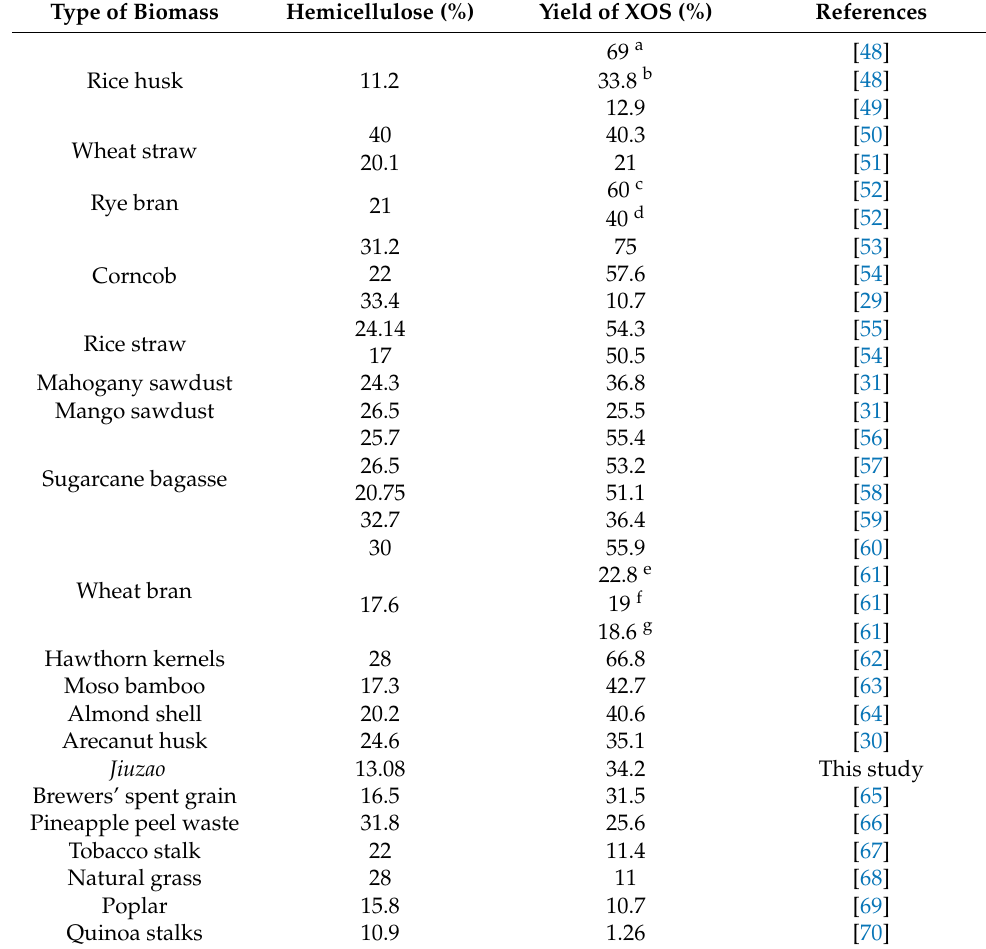
Table 4. Summary of representative XOS productions from different lignocellulosic materials. Type of